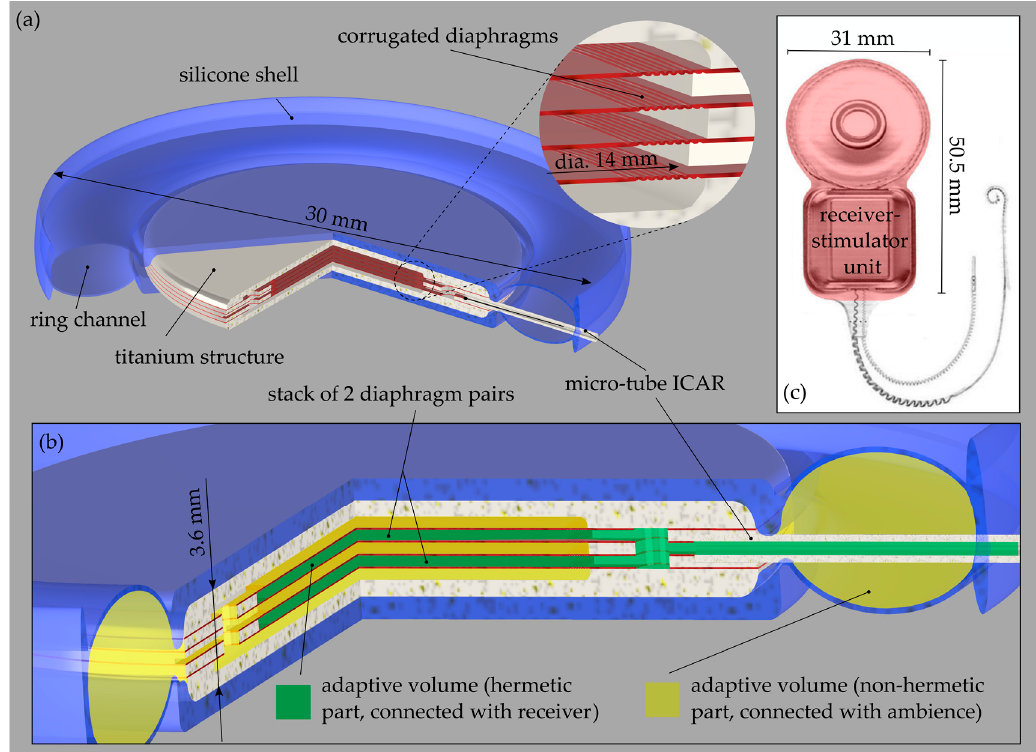
Figure 11. ( a ) CAD drawings (three quarter section view) of the static pressure equalization (SPEQ) system which is based on an adaptive volume (AV) structure integrated in the stimulator-receiver unit of the cochlear implant (CI) system. ( b ) Zoomed view onto the interior of the AV structure. The colours indicate the two parts of the pneumatic system. Green is the hermetic part connected to the receiver and yellow the non-hermetic part connected to the ambience over the ring channel (see legend). ( c ) The CI system (Type Nucleus CI512 Cochlear Ltd., Sydney, Australia) with relevant dimensions. Red colour indicates the receiver-stimulator unit of the CI, which is foreseen for the integration of the AV of the SPEQ system.